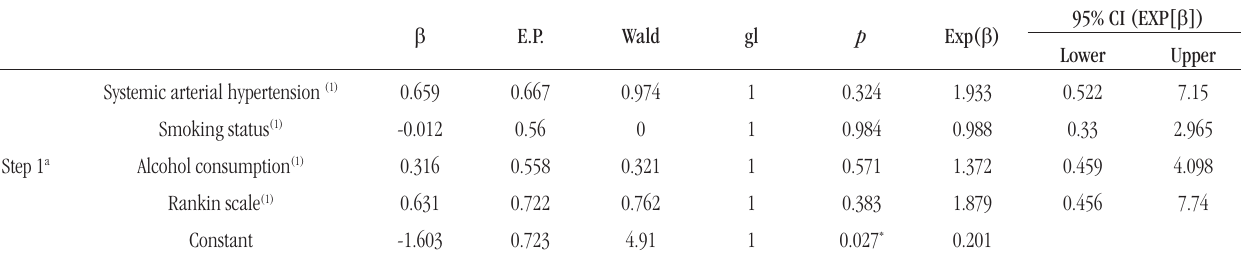
taBLE 5 − Multivariate logistic regression for genotyping (presence of GG genotype) according to the factors included in the model